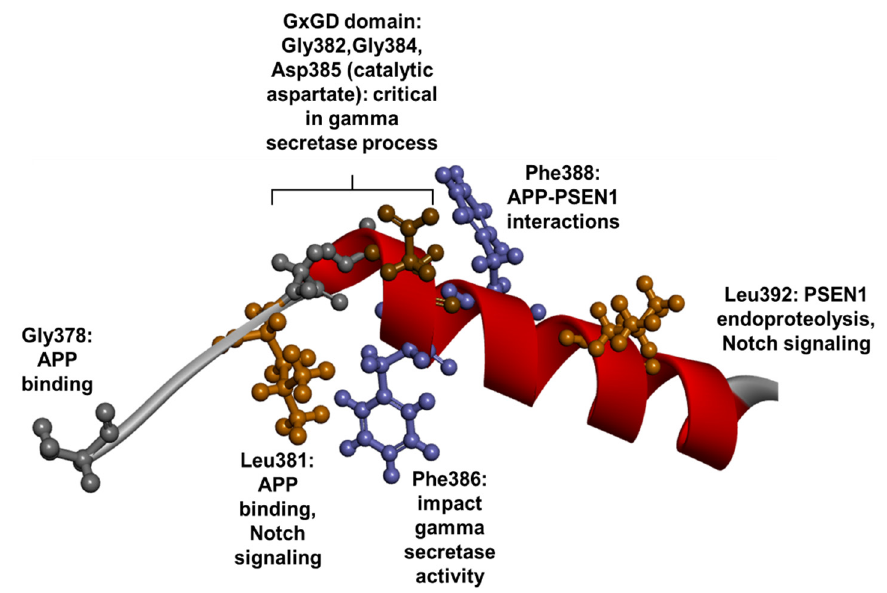
Figure 11. Significant residues in TM7 and HL7